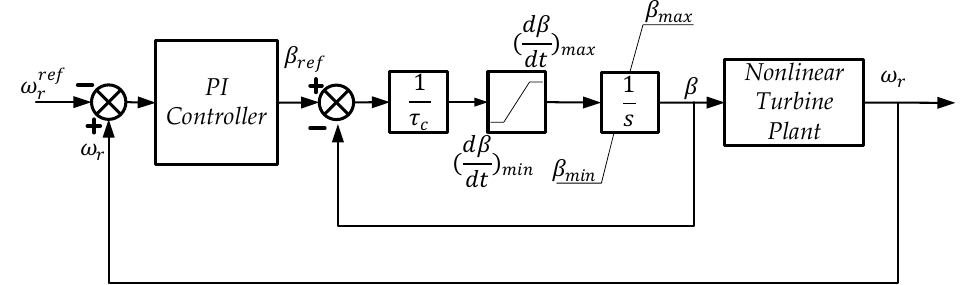
Figure 2. Typical PI control block diagram of a wind turbine pitch angle controller .